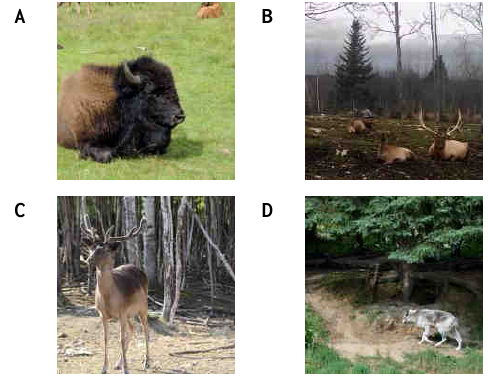
Figure 2. Studied species. A . American bison ( Bison bison ); B . elks ( Cervus canadensis ); C . fallow deer ( Dama dama ); and D . grey wolf ( Canis lupus ). © L.-P. Chrétien, E. Gavelle